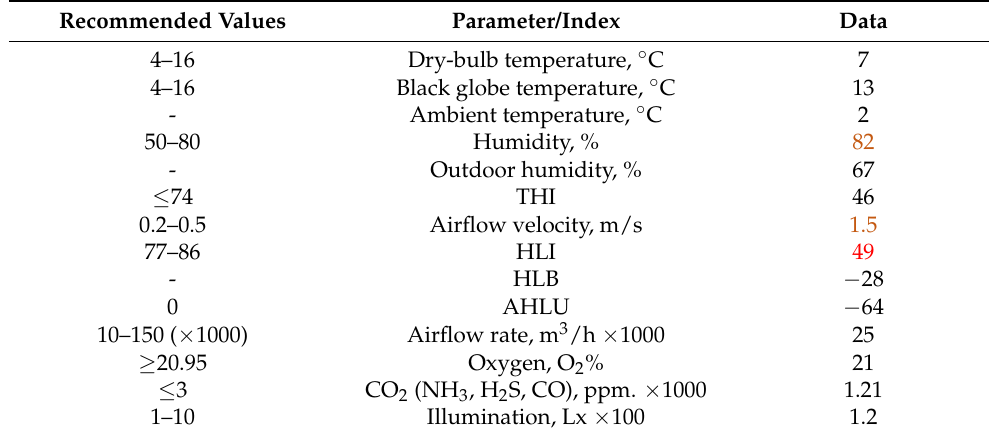
Table 2. Microclimatic conditions and indices at 03:00 (24 h).